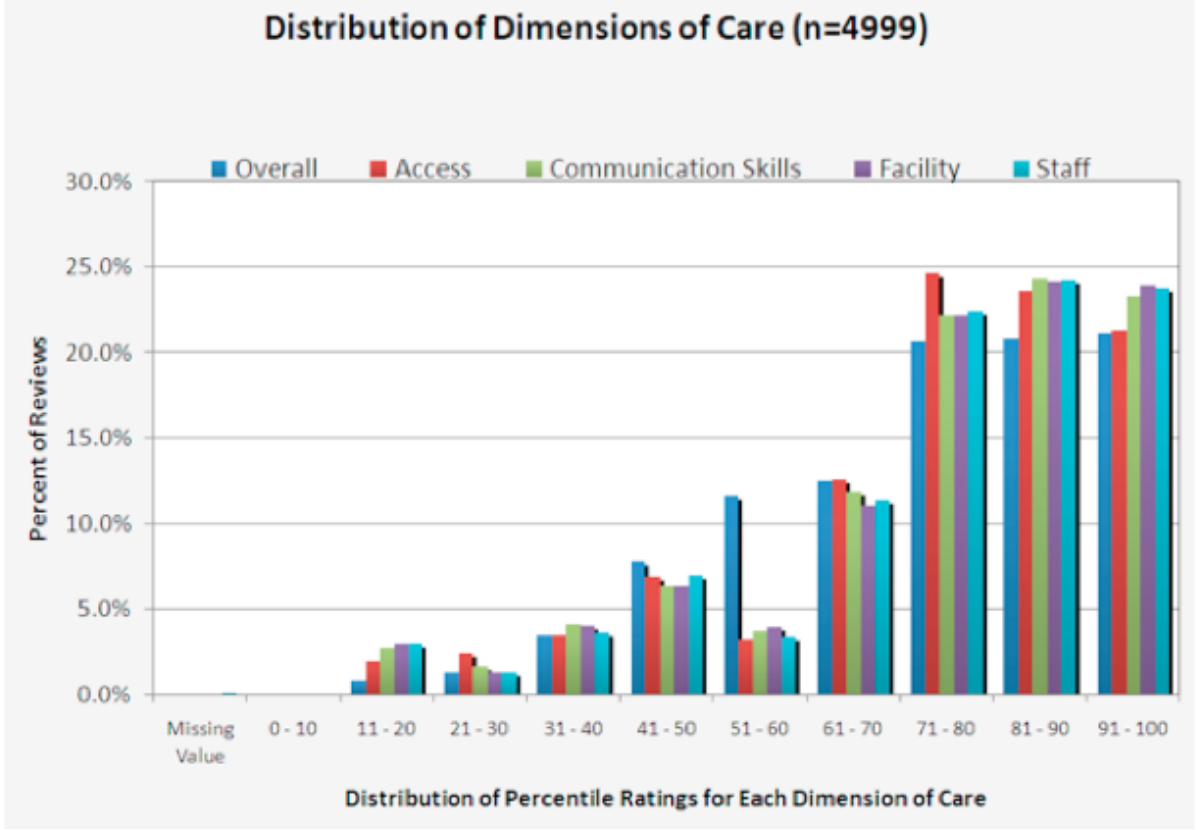
Figure 1. Distribution of percentile ratings for each dimension of care rated on all physician-review sites.